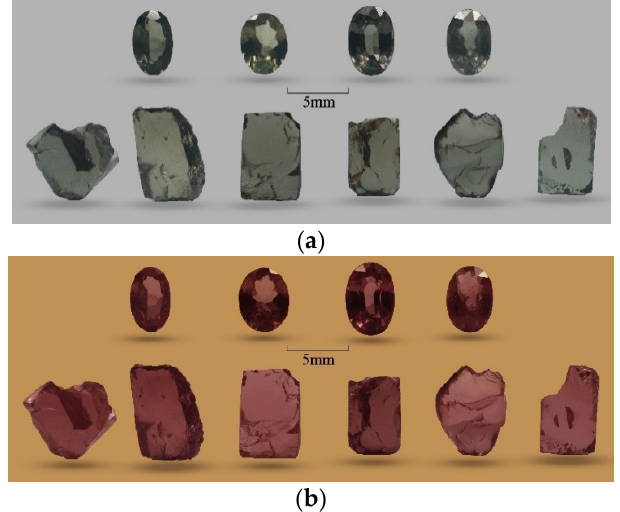
Figure 1. Photograph of 10 samples of colour-changing garnets. ( a ) Gray-green under standard D65 light. ( b ) Purplish red under standard A light.